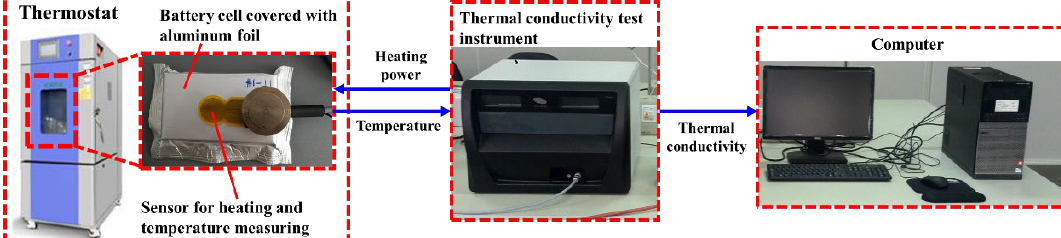
Figure 4. Test devices for cell thermal conductivity.